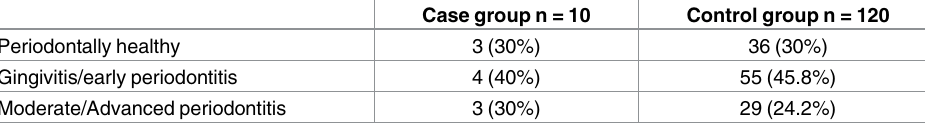
Table 3. Distribution of case and control groups attending to the periodontal